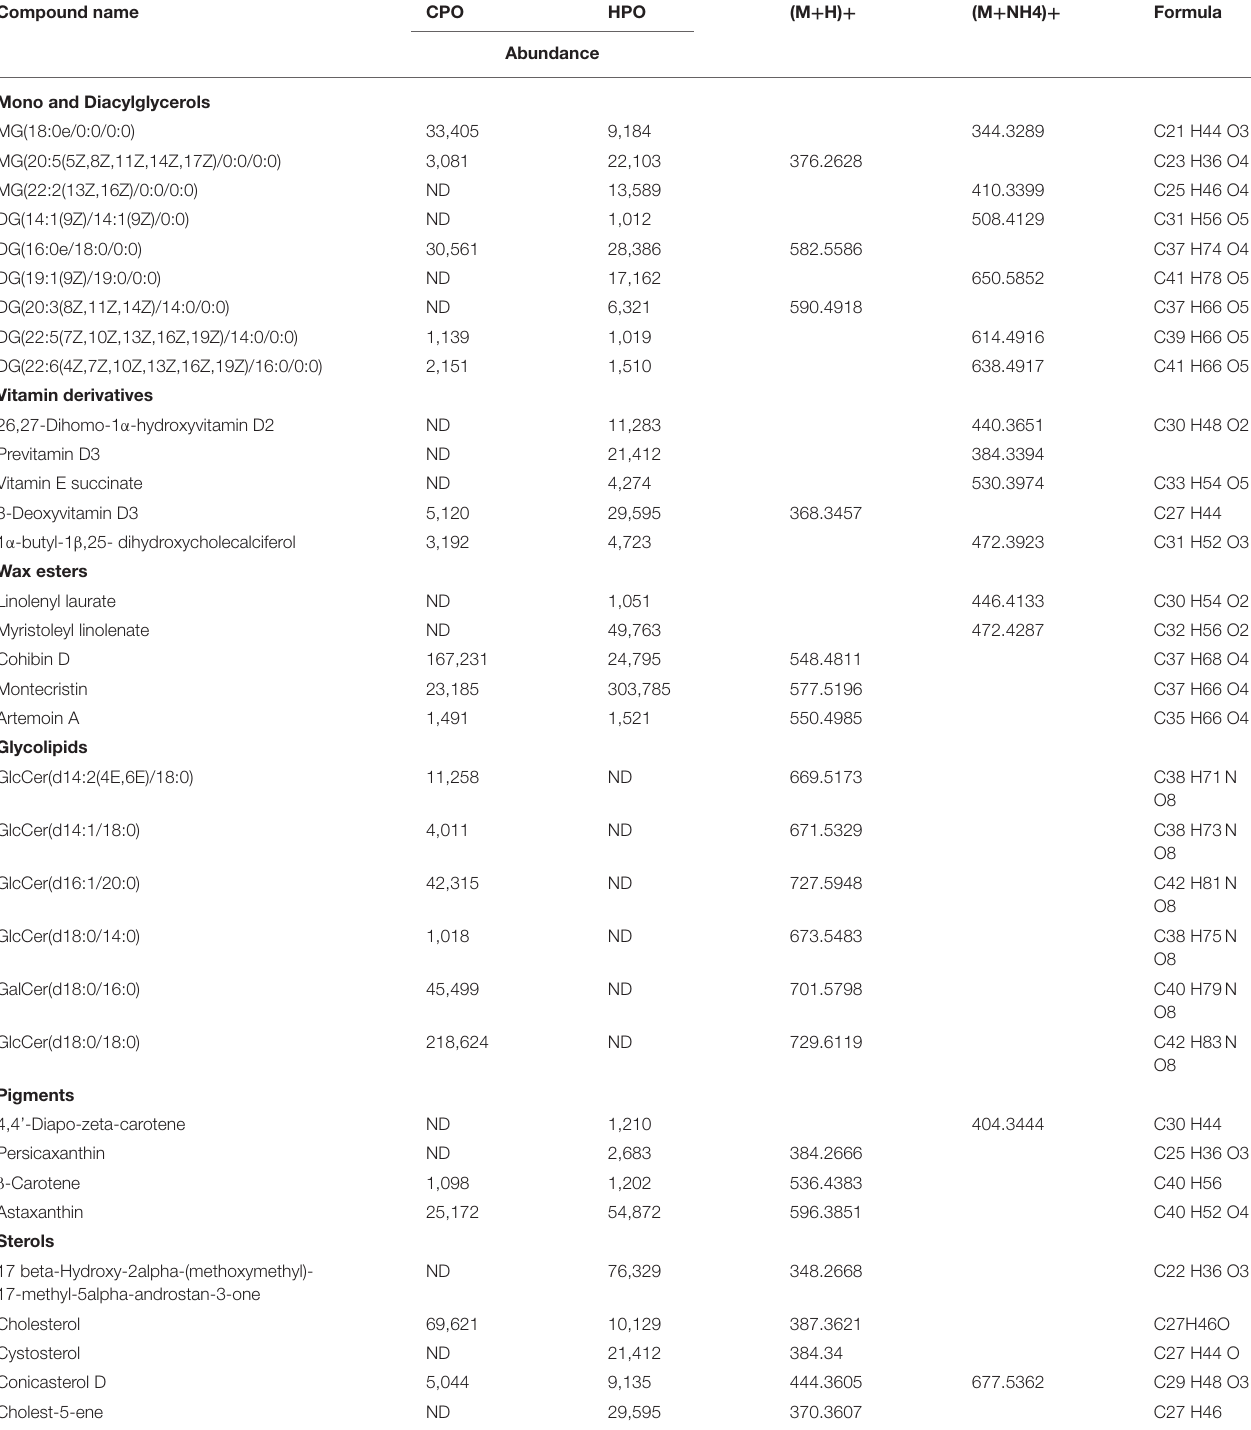
TABLE 2 | LC-MS identification of shrimp oil extracted from cephalothorax and